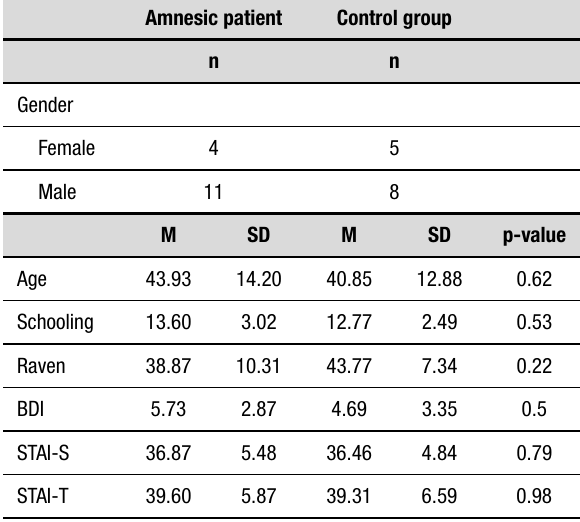
Table 2. Demographic and clinical characteristics and subjective symptoms of depression and anxiety of the whole